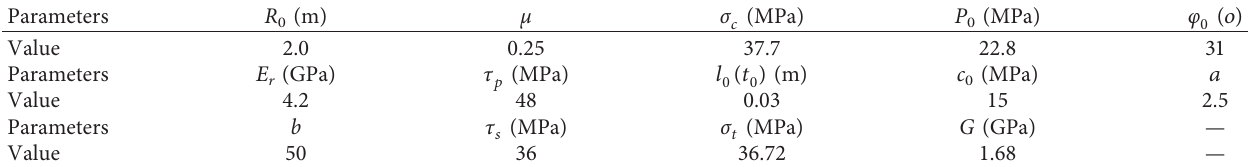
Table 1: Calculation parameter values of the Qinling water diversion tunnel.